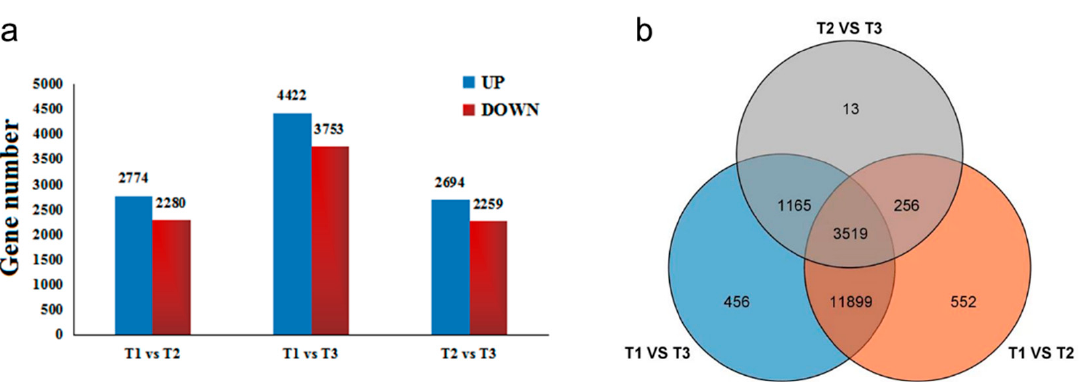
Figure 6. ( a ) Differentially expressed genes (DEGs) among three developmental stages of HSK flowers; ( b ) Venn diagram of differentially expressed genes in three developmental stages of HSK flowers. The UP and DOWN were representing upregulation and downregulation genes, respectively.